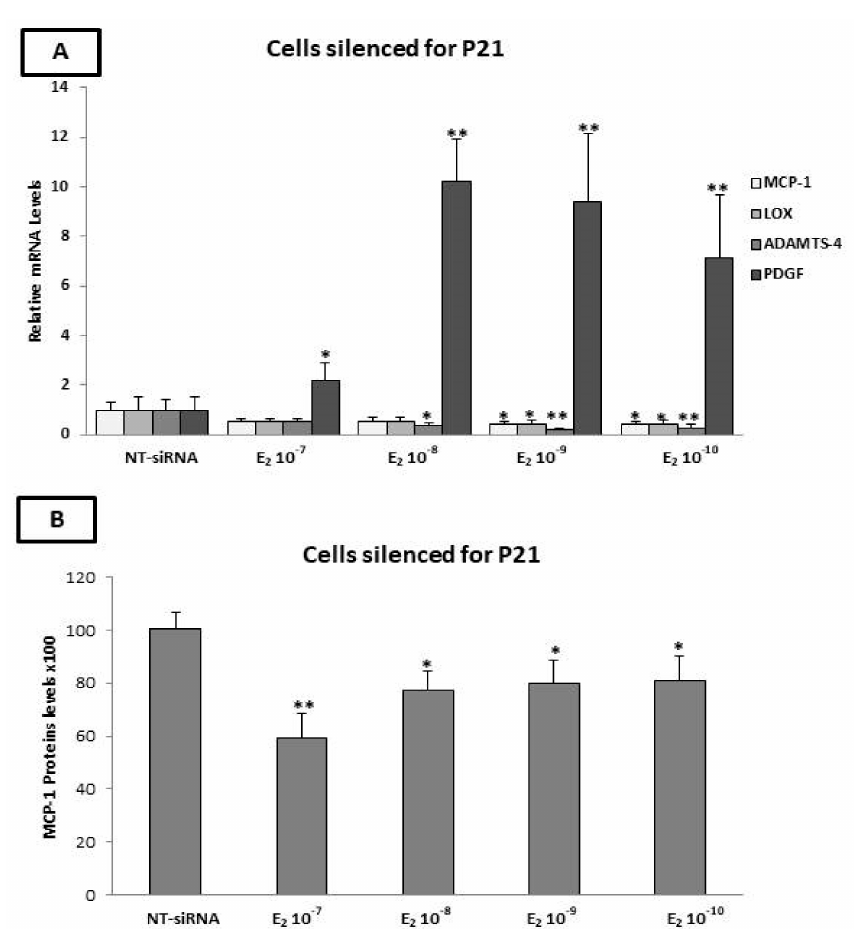
Figure 6. Effect of E 2 on the expression of factors involved in plaque stability in p21-silenced HAECs. ( A ) Incubation of p21-silenced cells with E 2 resulted in the induction of PDGF- β (10 − 10 − 10 − 7 M of E 2 ) and reduction in MCP-1 (10 − 10 − 10 − 9 M of E 2 ), LOX-1 (10 − 10 − 10 − 8 M of E 2 ) and ADAMTS-4 (10 − 10 M of E 2 ) mRNA levels. ( B ) Incubation of p21-silenced cells with E 2 resulted in reduced MCP-1 protein levels (10 − 10 − 10 − 7 M of E 2 ). The graphical data are represented as mean ± SD of at least three independent experiments (** p < 0.01, * p <